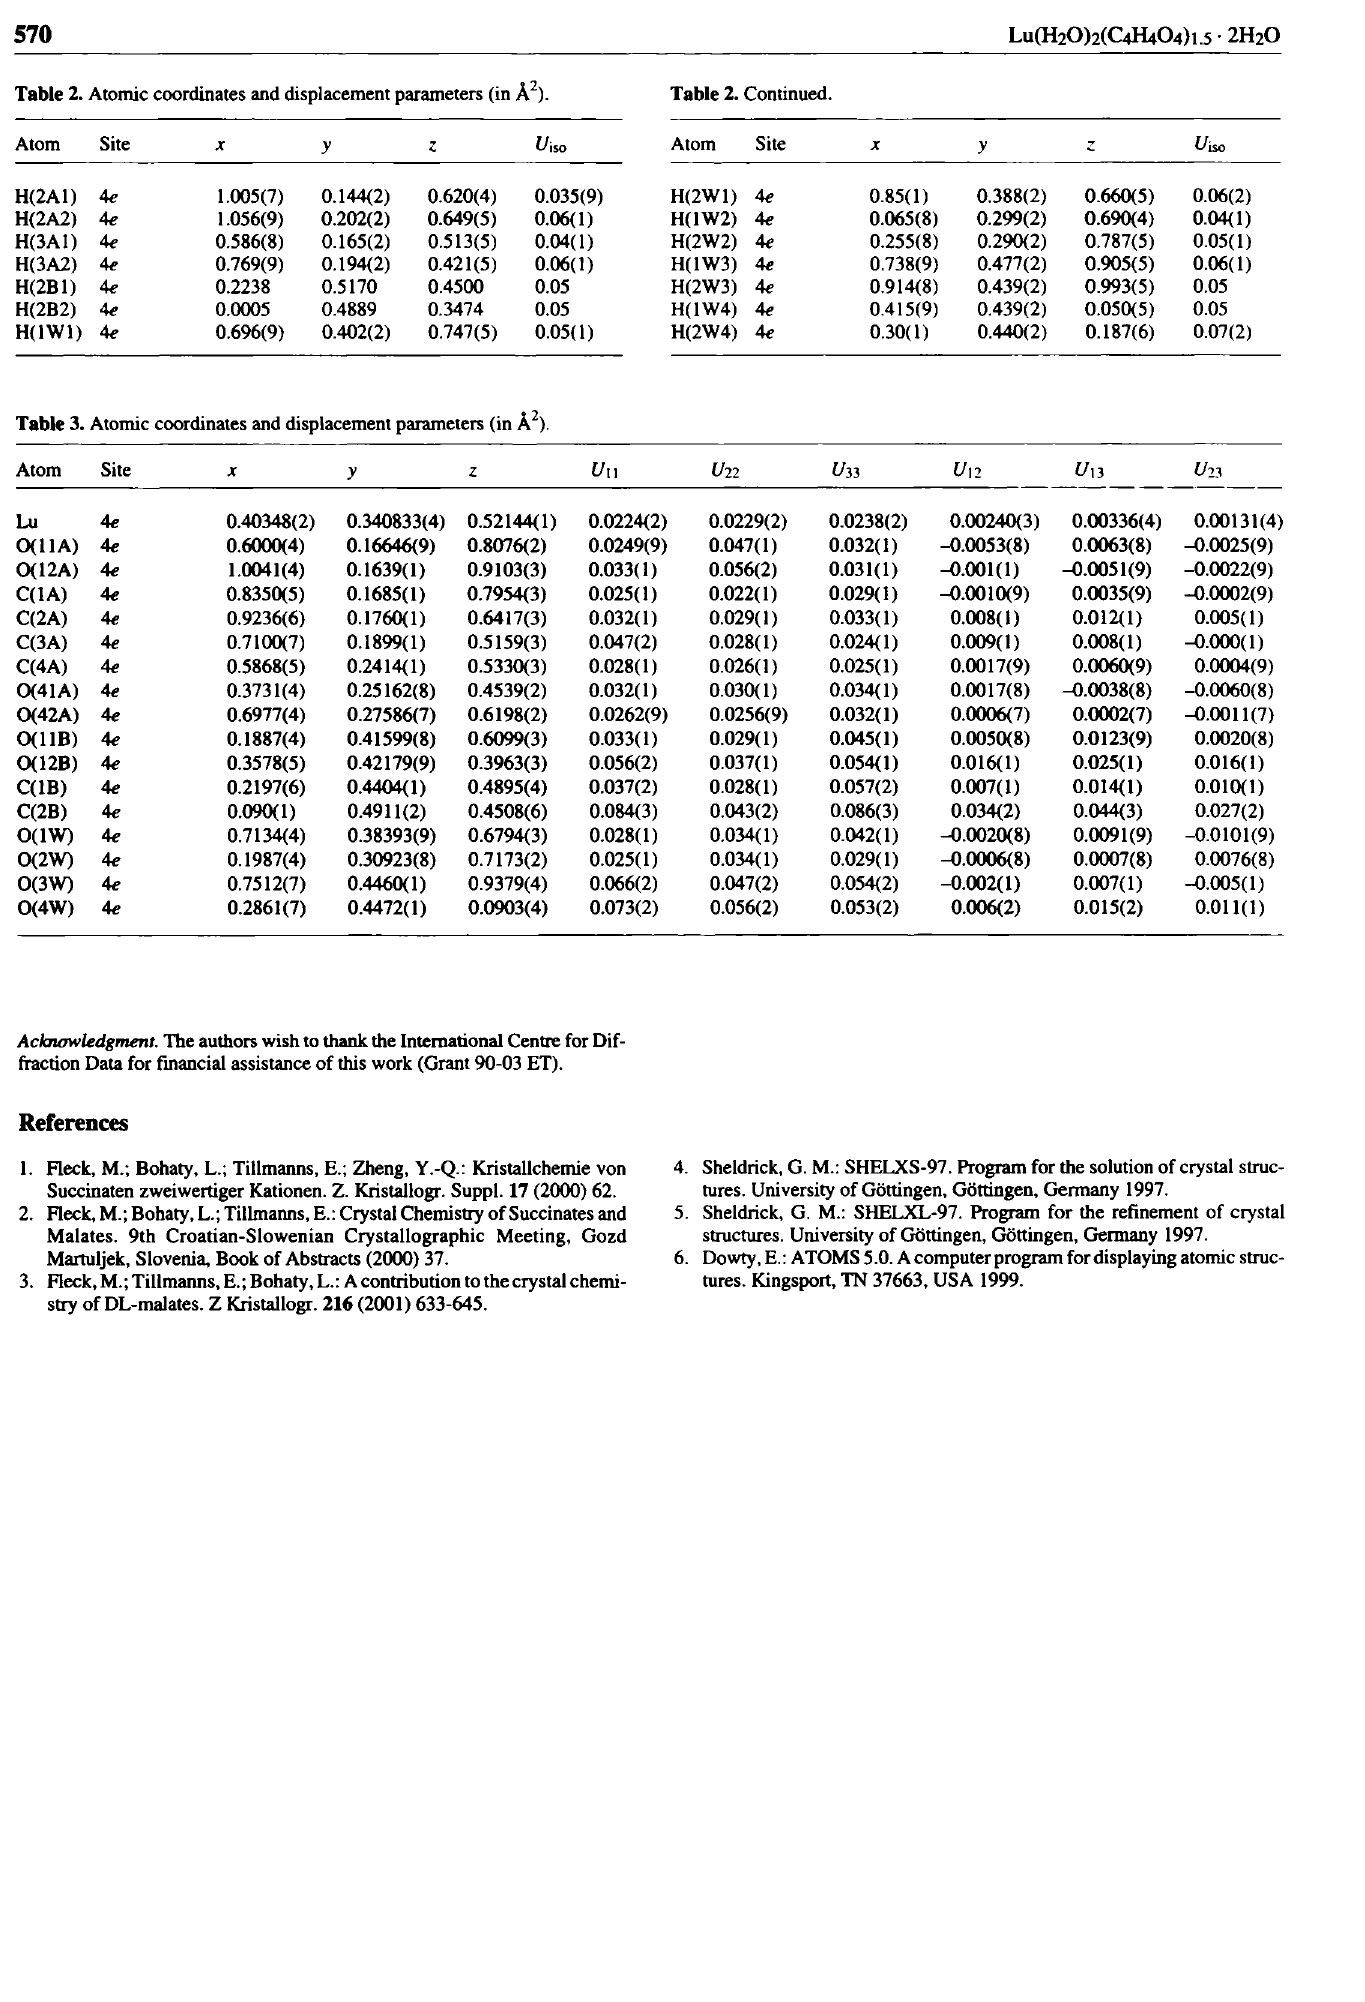
Table 2. Atomic coordinates and displacement parameters (in Â 2 ).